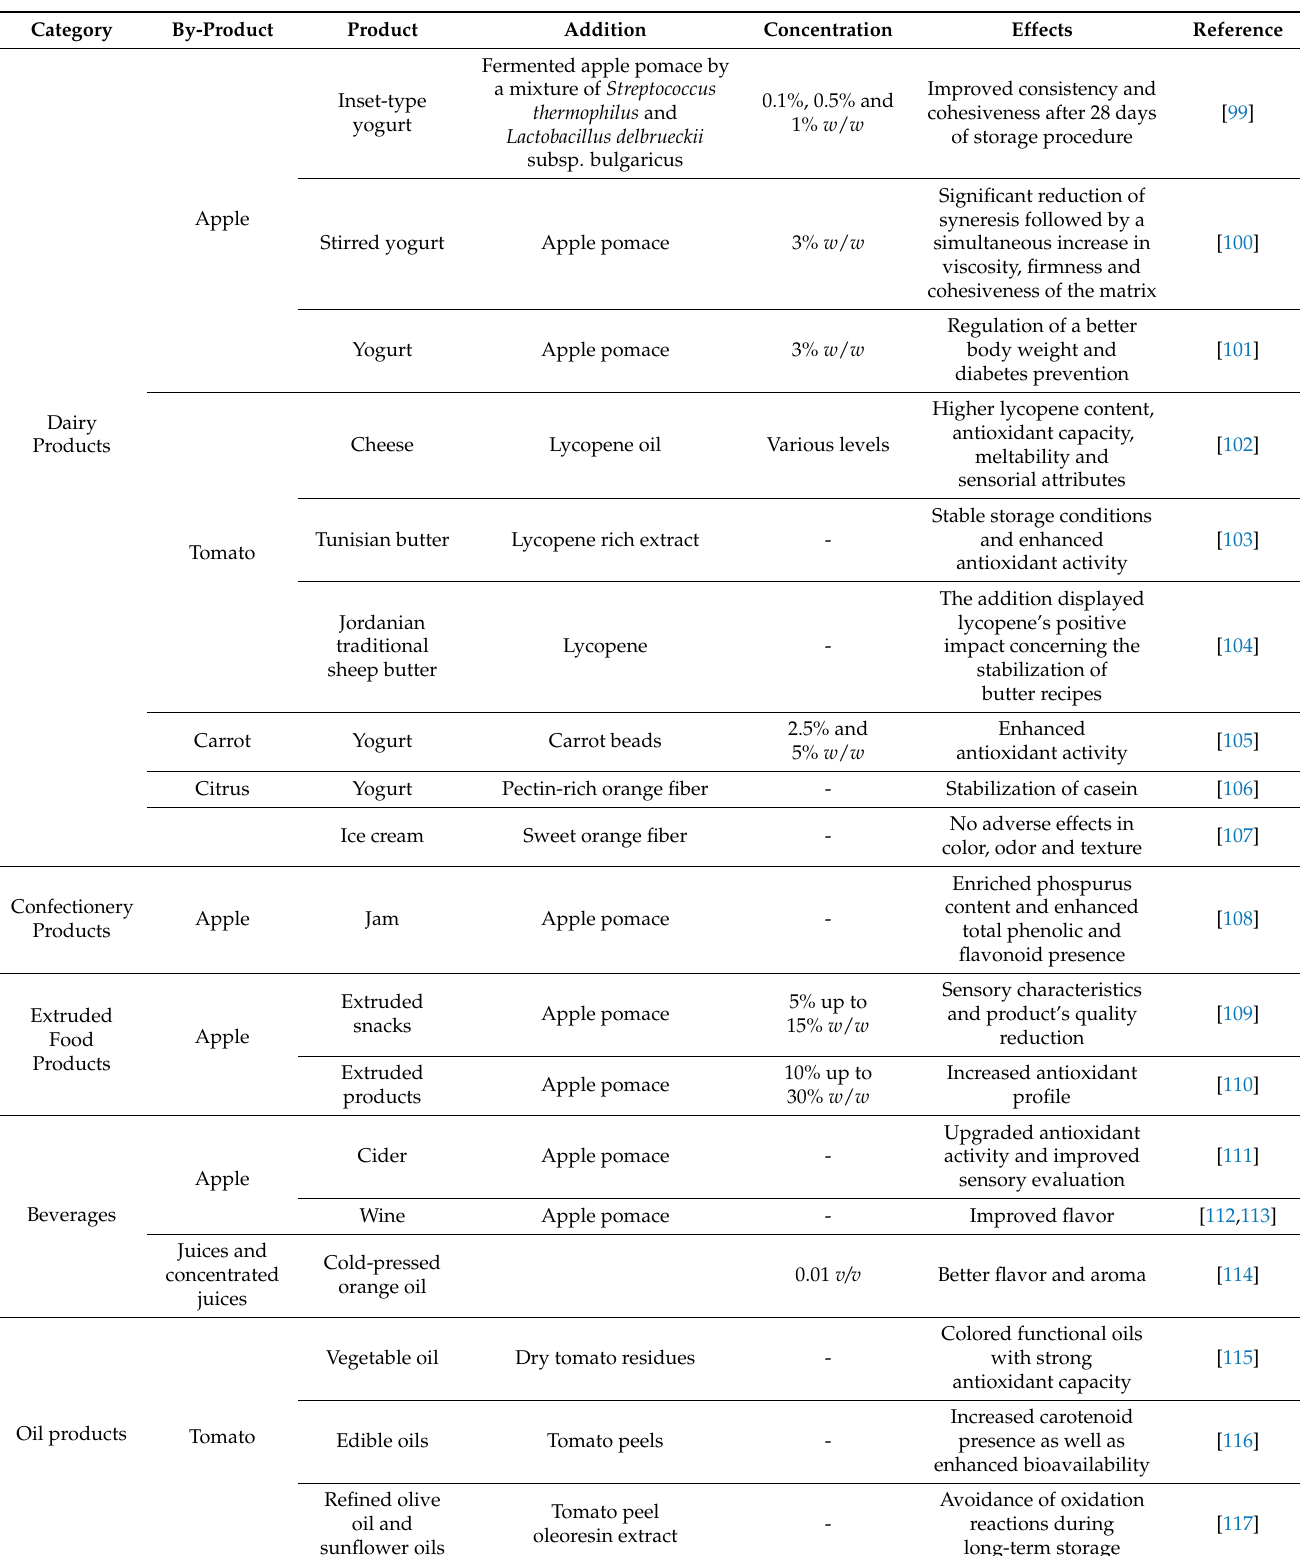
Table 4. Addition of agri-food by-products to other food